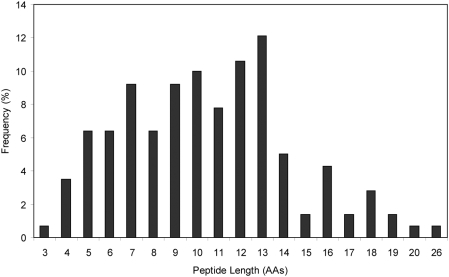
Analysis of peptides released from Hb following digestion by FheCL1.Frequency (expressed as a percentage) of peptides of varying length released following proteolysis of Hb alpha and beta chains by FheCL1.